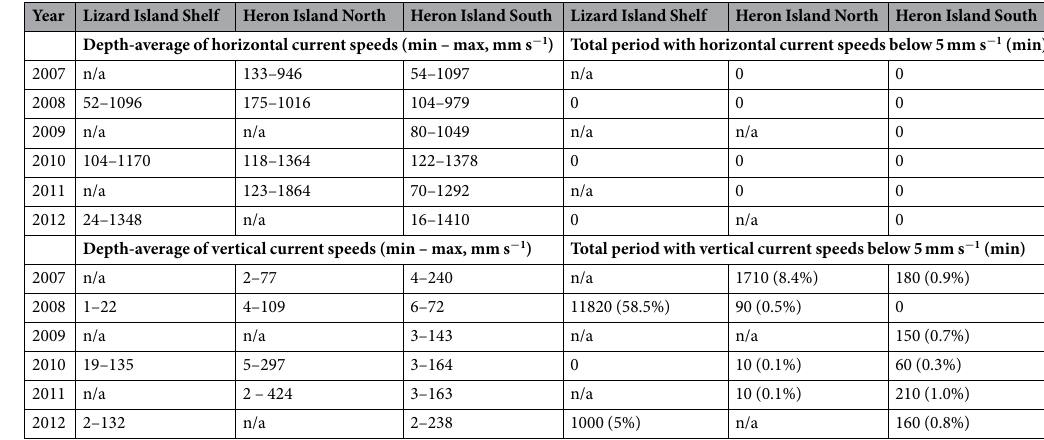
Table 2. Minimum and maximum observed current speeds (left-hand panes) during the 2 weeks following coral mass spawning in 6 successive years at 3 locations in the Great Barrier Reef, and the total length (and percentage) of time during this two-week period when current speeds were under 5 mm s − 1 (right-hand panes). The speeds shown are averages of the speeds of horizontal (upper table) and vertical (lower table) currents over the top 20 m of the water column, and were obtained from the Great Barrier Reef Ocean Observing System 23 . Years for which data were not available are marked as